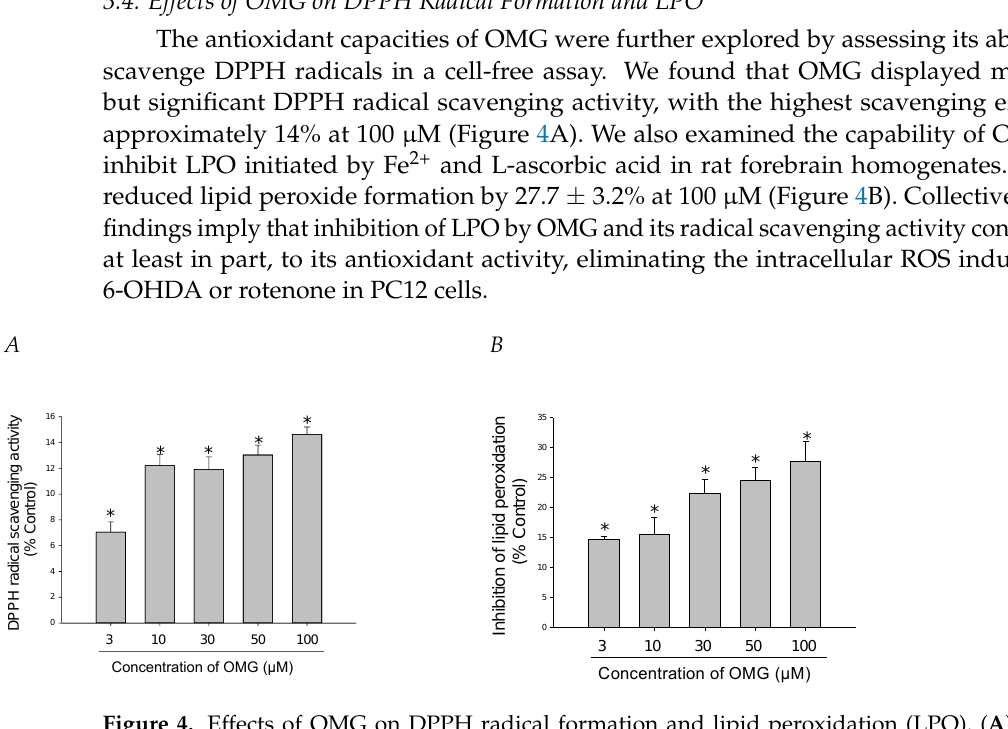
Figure 4. Effects of OMG on DPPH radical formation and lipid peroxidation (LPO). ( A ) DPPH radical formation and ( B ) LPO initiated by Fe 2+ (10 µ M) and L-ascorbic acid (100 µ M) in rat forebrain homogenates were evaluated as described in the Materials and Methods section. Data are displayed as the mean ± SEM from three independent experiments conducted in duplicate. *, p < 0.05 vs. DPPH radicals and LPO measured in the absence of OMG, respectively. OMG, omarigliptin; DPPH, 1,1-diphenyl-2-picrylhydrazyl; LPO, lipid peroxidation.